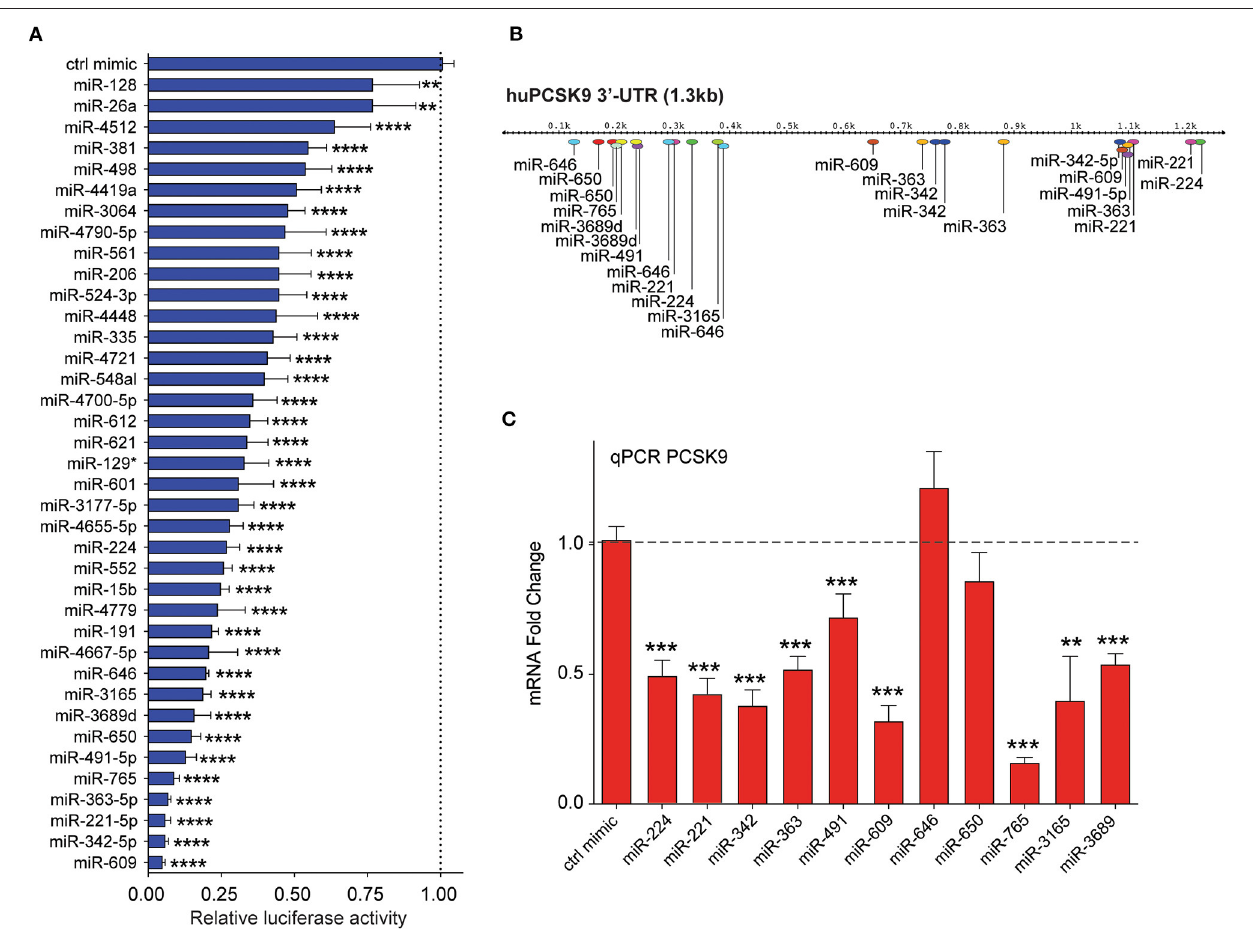
FIGURE 3 | Secondary screening of top miRNA candidates targeting human PCSK9 . (A) Relative luciferase activity of PCSK9 3 ′ -UTR luciferase reporter construct in HEK-293T cells transfected with miRNA mimics for the top 35 hits identified from the primary screen. MiR-224 was included as a positive control. Data are presented as percent of control mimic ± standard deviation of three independent experiments. (B) Alignment of miRNA binding sites for the top 10 candidate miRNAs on the human PCSK9 3 ′ -UTR. (C) qRT-PCR analysis of PCKS9 expression in HepG2 cells transfected with the top 10 candidate miRNAs or control mimic. Data are the mean ± standard deviation from three independent experiments. p -Values were calculated by one-way ANOVA and corrected for multiple comparison by Dunnet’s post-hoc test (A) or a two-tailed Student’s t -test (C) . * p < 0.05, ** p < 0.01, *** p < 0.001, **** p <